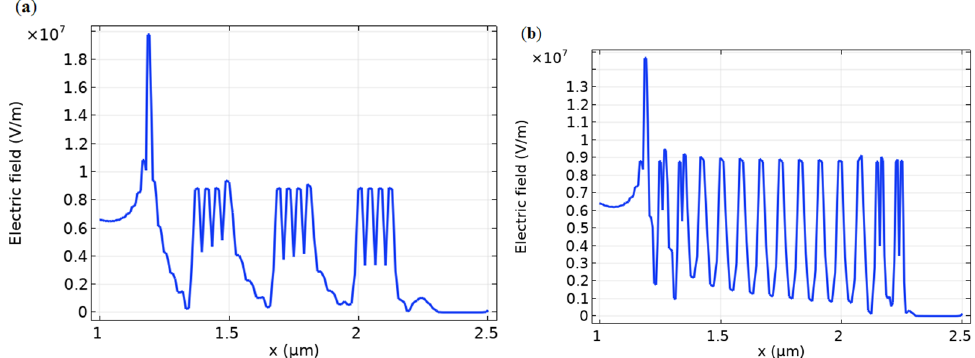
Figure 8. Electric field with charged islands on the surface. The number of charged islands is 3 pieces ( a ), and 14 pieces ( b ). U ct = 0.5 V, U an = 1 V, U g = 3 V. Cutline Y = 0.70 μ m. GaAs, p -type, p = 10 12 cm − 3 . Surface charge density ρ = 10 − 3 C · m − 2 is situated at each island.